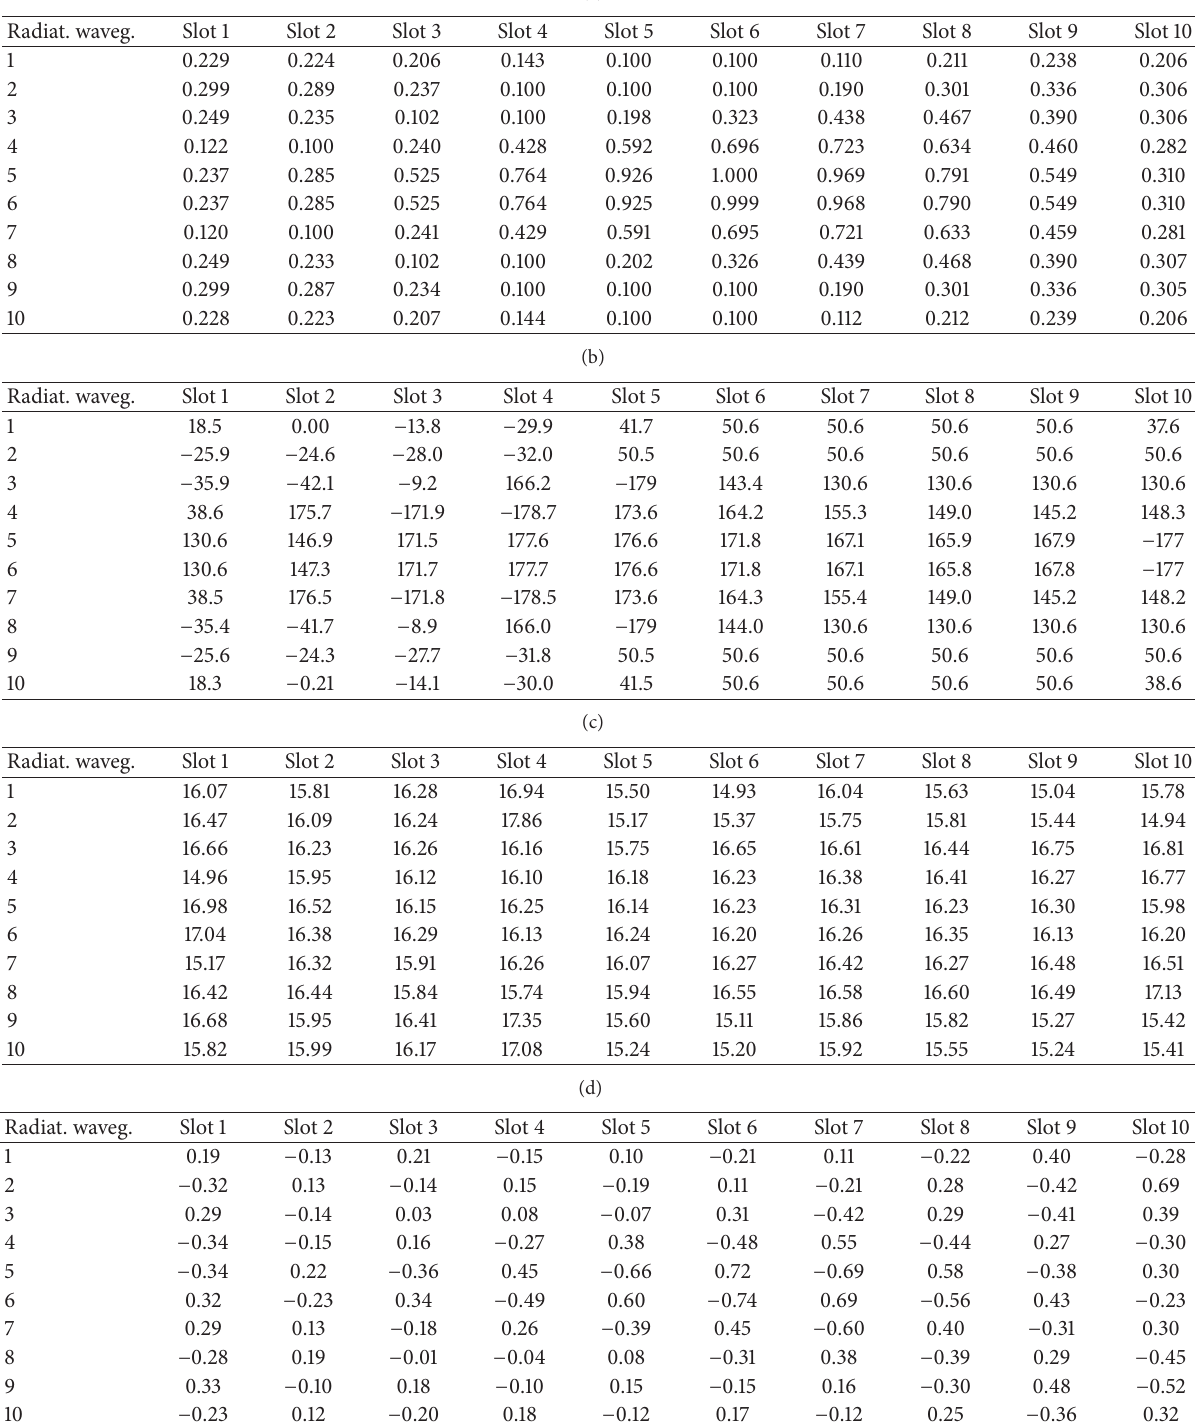
Table 2: (a) Required normalized amplitude of slots excitations for the 10 × 10 planar array with an arrow-shaped radiation pattern. (b) Required phase (degrees) of slots excitations for the 10 × 10 planar array with an arrow-shaped radiation pattern. (c) Designed slots lengths (mm) for the 10 × 10 planar array with an arrow-shaped radiation pattern. (d) Designed slots offsets (mm) for the 10 × 10 planar array with an arrow-shaped radiation pattern. (a) Radiat. waveg.